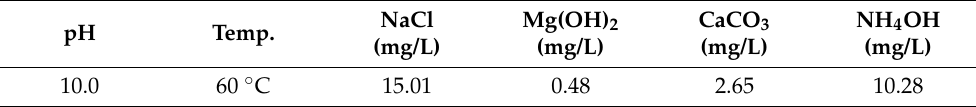
Table 2. Composition of DH water.